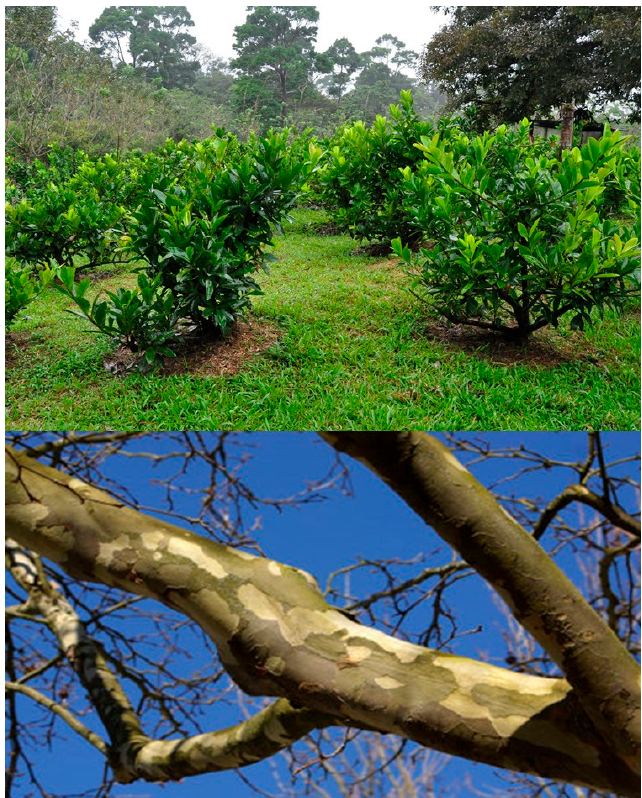
Figure 2. Souroubea growing sustainably in plantation ( top ) and Platanus tree trunk showing peeling bark which is harvested without harming the tree ( bottom ).